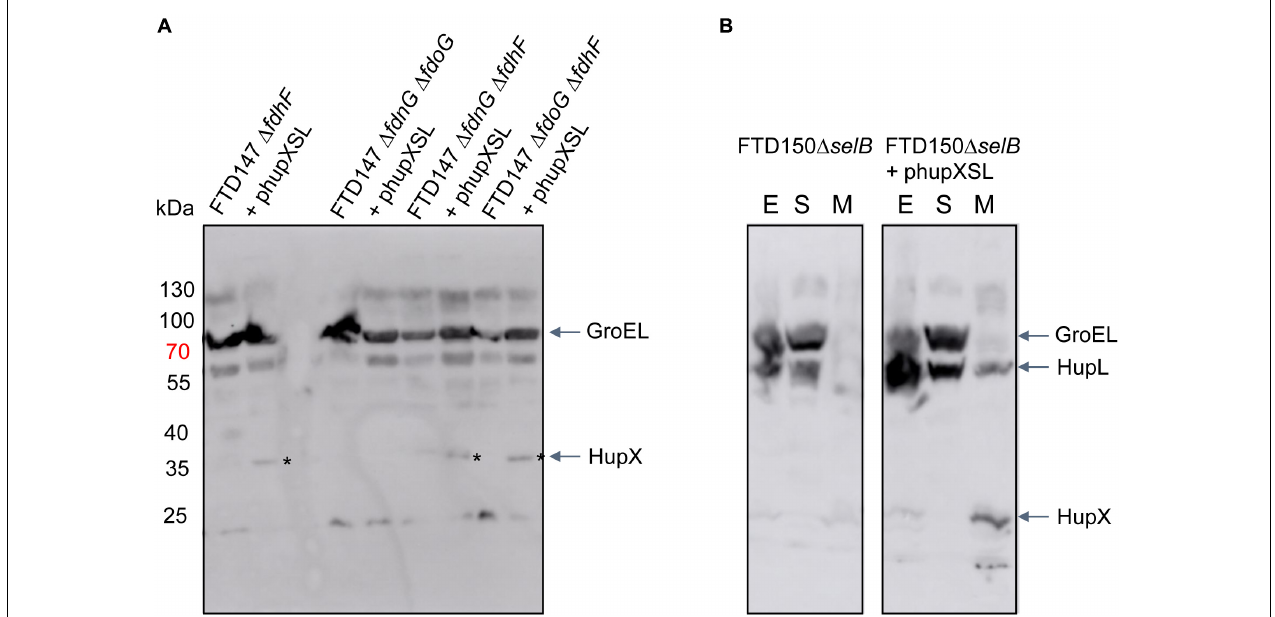
FIGURE 5 | HupX is only detectable in extracts of strains lacking the fdhF gene. Western blots using peptide antibodies raised against HupX or HupL are shown in which 50 µ g of crude extracts (A) or subcellular fractions (B) were separated in 10% (w/v) SDS-PAGE. The migration positions of molecular mass marker proteins are shown in kDa. The strong signal migrating around 70 kDa represents GroEL, which cross-reacted with the HupX antibodies, and acted as a protein loading control. The asterisks denote the HupX polypeptide. In (B) , the letters E, S, and M represent crude extract, soluble cytoplasmic fraction and membrane fraction, respectively. Strain used include: deletion derivatives of FTD147 ( (cid:49) hyaB (cid:49) hybC (cid:49) hycE ); and deletion derivatives of FTD150 ( (cid:49) hyaB (cid:49) hybC (cid:49) hycE (cid:49) hyfG